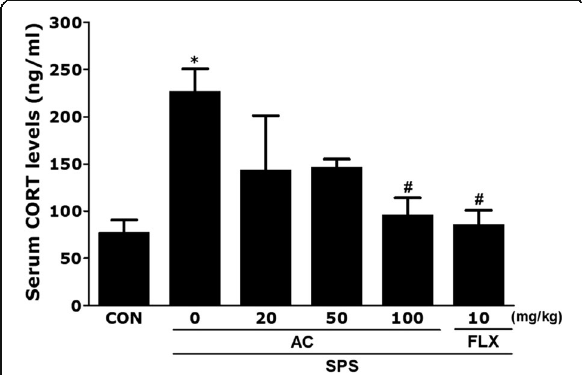
Fig. 3 Effects of AC on serum corticosterone (CORT) levels in rats with SPS-induced memory impairment. Results were analyzed by enzyme-linked immunosorbent assay ( n = 4/group). * p < 0.05 vs. the CON group, # p < 0.05 vs. the SPS